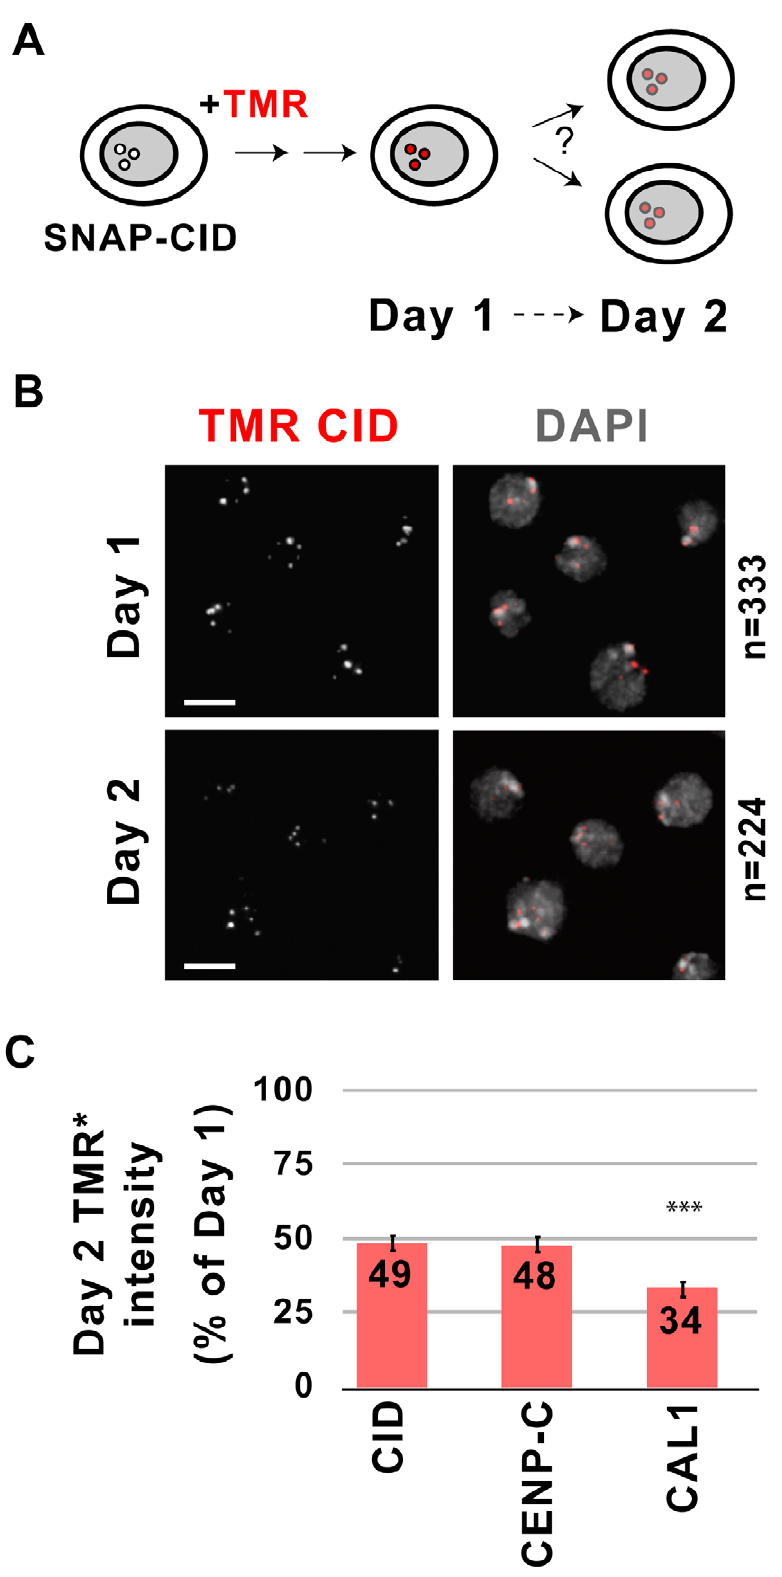
Figure 1. Inheritance of centromeric proteins through cell division. A) Experimental design for monitoring dilution of centromeric proteins during cell divisions. Clonal S2 SNAP-CID cells were incubated with TMR to fluorescently label CID. TMR-CID signal intensity was then quantified 24 h after labeling (Day 1) and 24 hours later (Day 2) to determine SNAP-CID distributions. B) Images from SNAP-CID cells imaged 24 h after TMR labeling (Day 1) and 24 hours later (Day 2). TMR-CID signal intensity (red) is reduced after one cell division. DAPI staining is shown in grey. n indicates the total